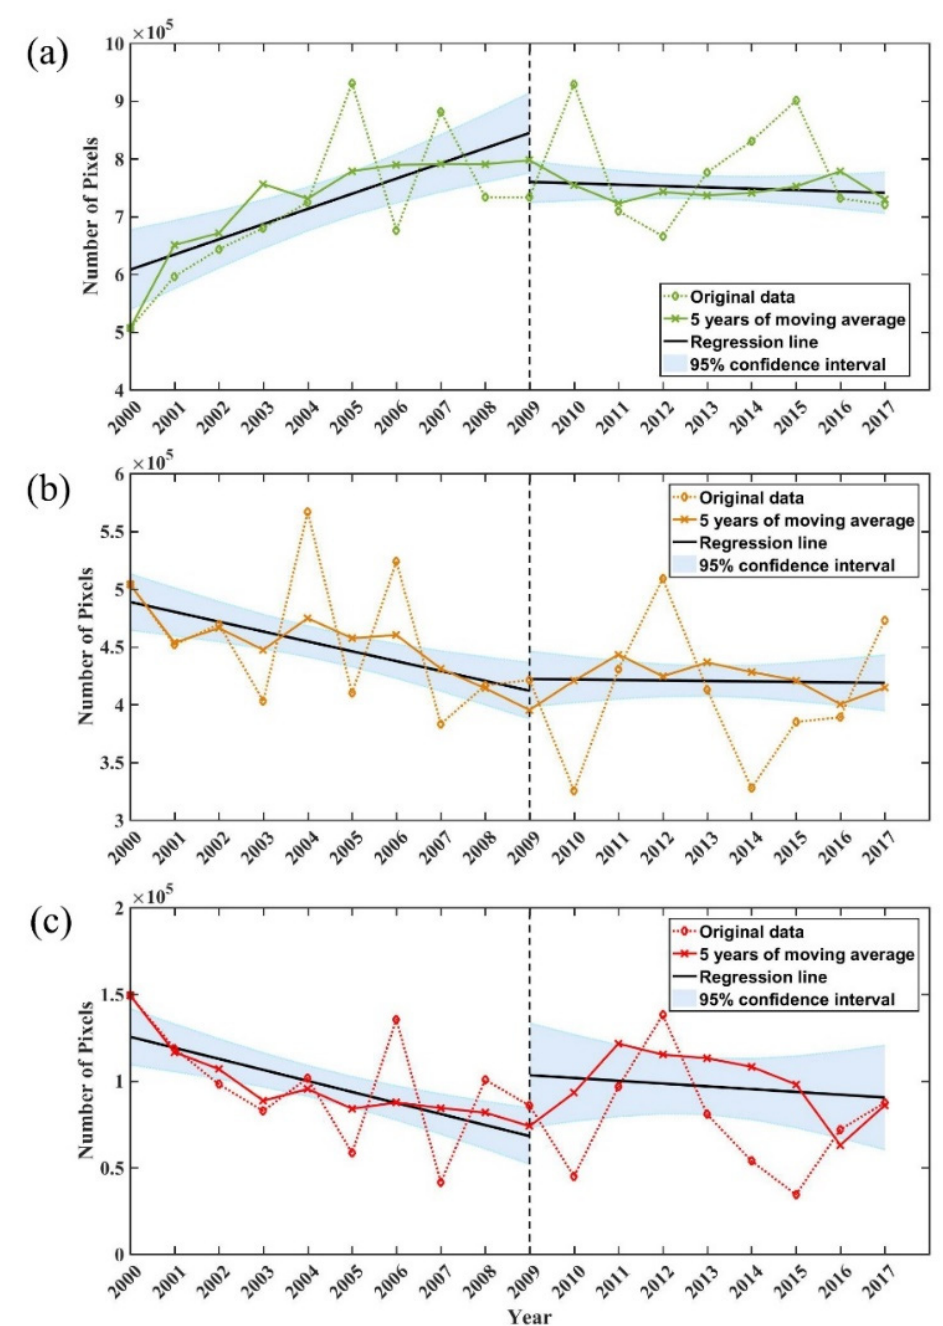
Figure 6. Variation trend of pixel numbers from 2000 to 2017 for ( a ) weak, ( b ) medium, and ( c ) strong sUHI. To reflect the spatiotemporal variation characteristics of the sUHI, the slope of LST R time series at the location of each pixel in three different period was calculated by the Theil–Sen regression method (Figure 7). A positive slope indicates an increasing sUHI, and a negative slope indicates a decreasing